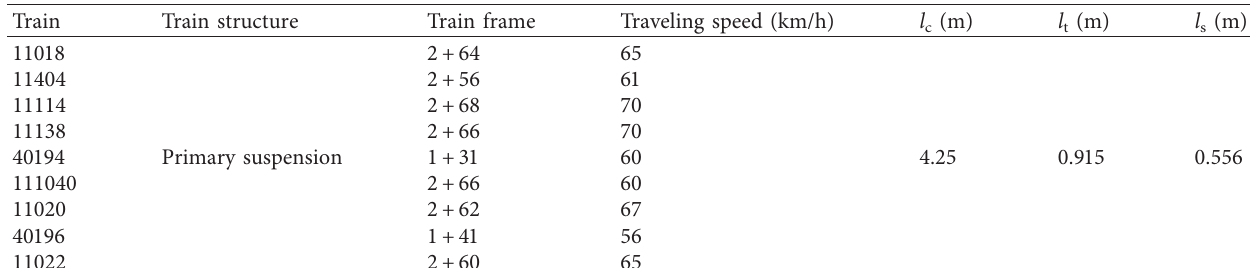
Table 1: Parameters of the monitoring train.